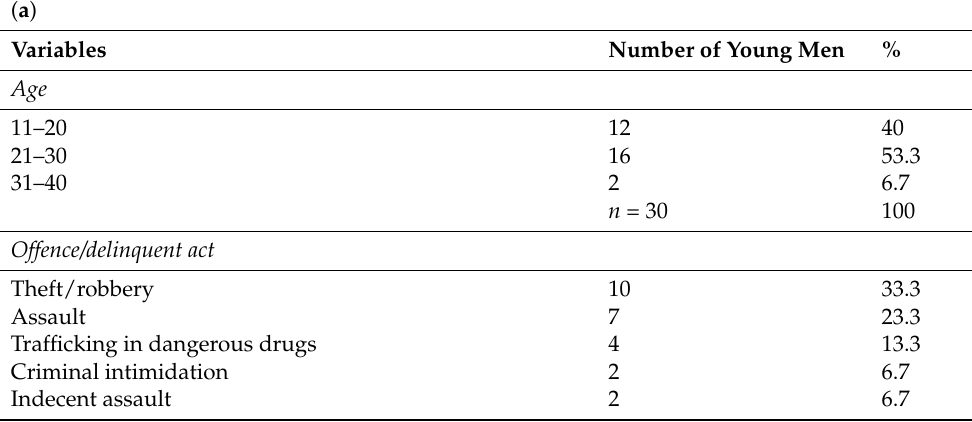
Table 2. ( a ) Demographic characteristics at the time of interview ( n = 30); ( b ) Male Respondents’ Demographic Characteristics ( n =